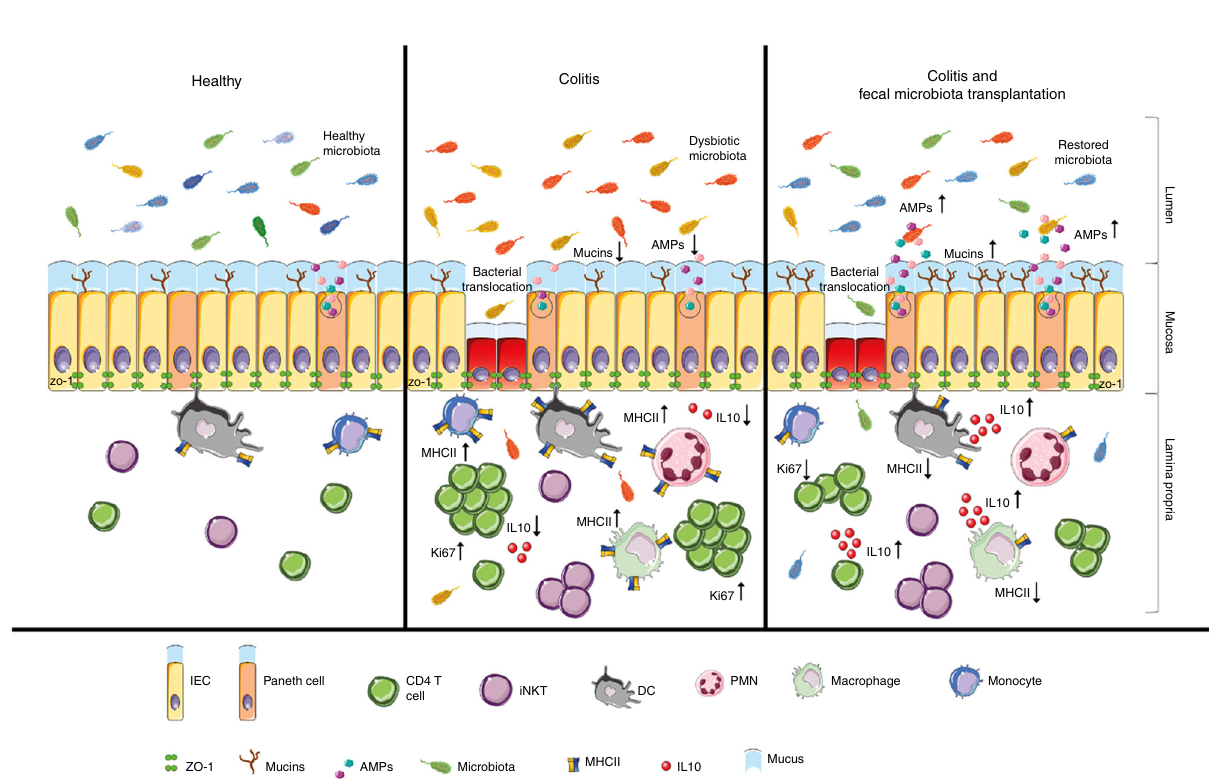
Fig. 9 Graphical abstract of events occurring in the intestinal mucosa in healthy conditions, during intestinal in fl ammation caused by DSS administration and during faecal transplantation in colitic mice. Adapted from SERVIER MEDICAL ART (CC BY 3.0